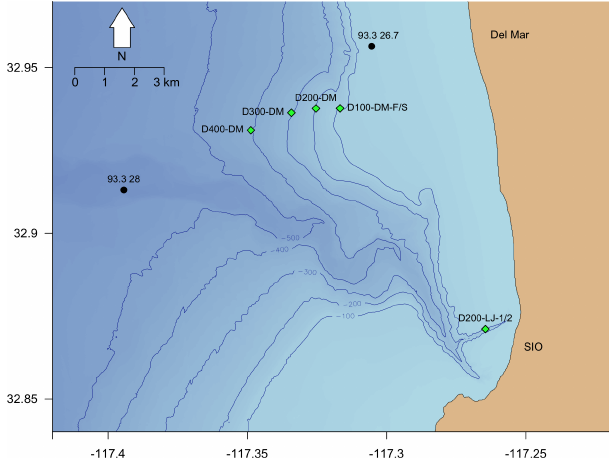
Figure 3. Map of Nanolander DOV BEEBE deployments shown in relation to local bathymetry and nearby stations sampled quar- terly by the California Cooperative Oceanic Fisheries Investiga- tions (CalCOFI). Green diamonds indicate Nanolander deploy- ments, black circles indicate CalCOFI stations with station labels, and isobaths show 100, 200, 300, 400, and 500m depth contours. Note that the green diamonds labeled D200-LJ-1/2 and D100-DM- F/S represent two deployments each, but points overlap due to prox-